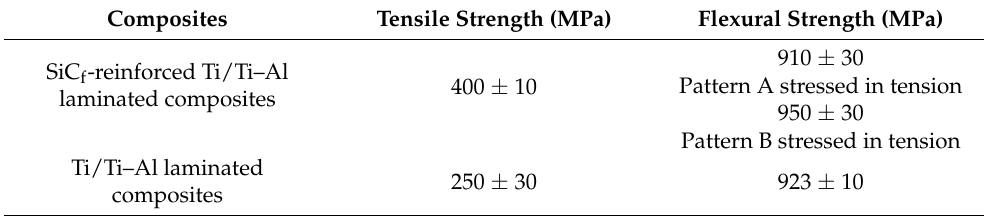
Table 4. Mechanical performance results of Ti/Ti–Al and SiC f -reinforced Ti/Ti–Al laminated com-